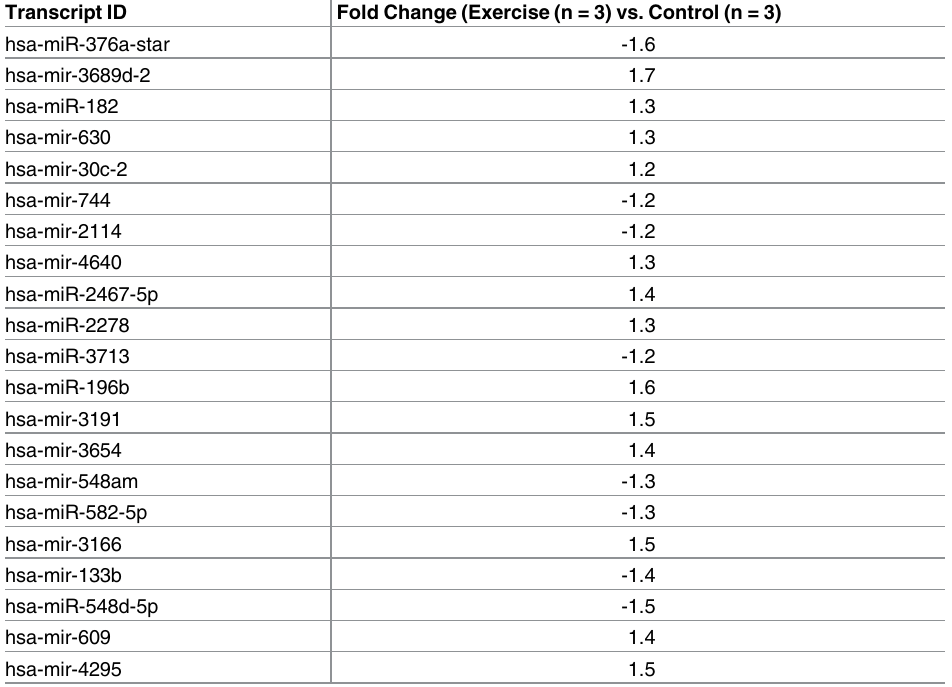
Table 1. Exercise-induced microRNAs. Transcript ID Fold Change (Exercise (n = 3) vs. Control (n =